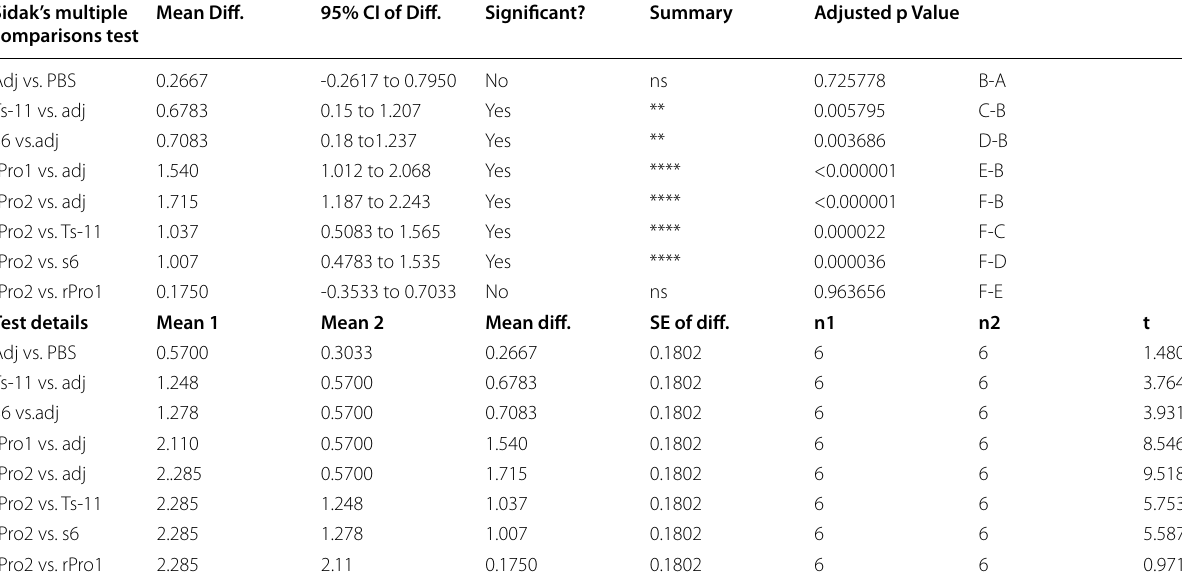
Table 1 Sidak’s multiple Comparisons test for six groups based on antibody levels in sera at 42 days after immunization. p < 0.0001( **** ), 0.0002(***), 0.0021(**) indicated significant differences Sidak’s multiple Mean comparisons test